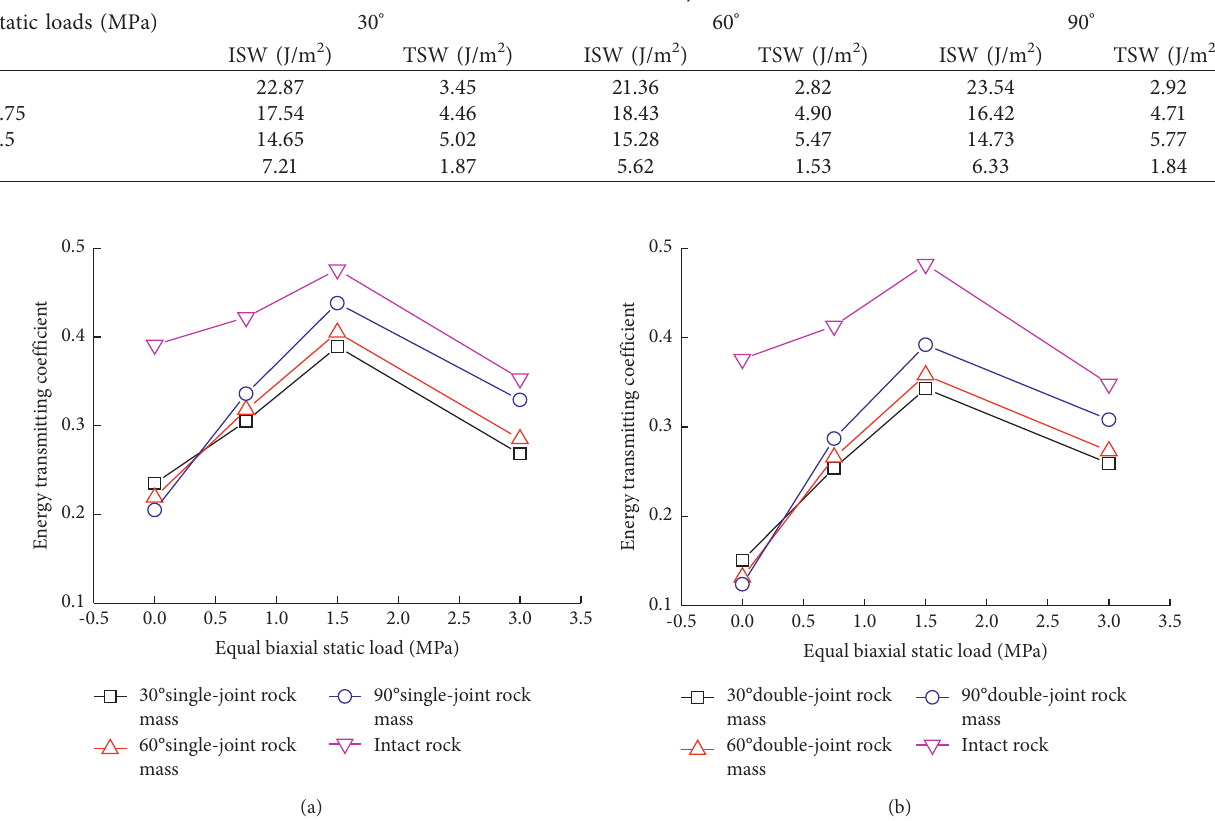
Table 5: Energy intensities of incident and transmitted stress wave in double-joints rock mass under different equal biaxial static loads. Static loads (MPa)